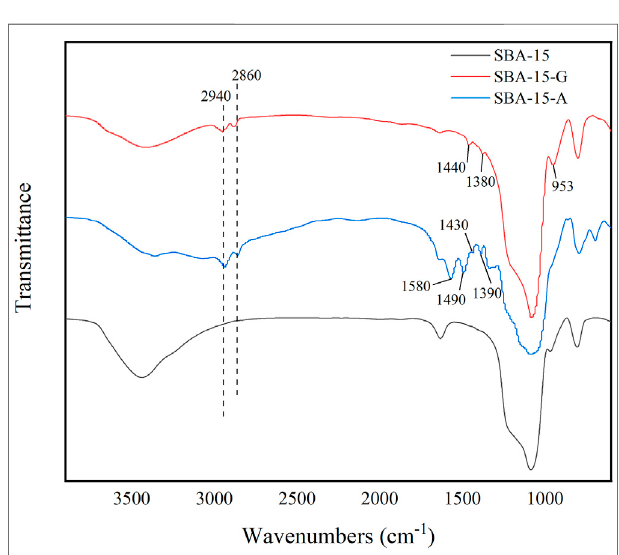
FIGURE 2 | The FT-IR diagram of SBA-15, SBA-15-A, and SBA-15-G.